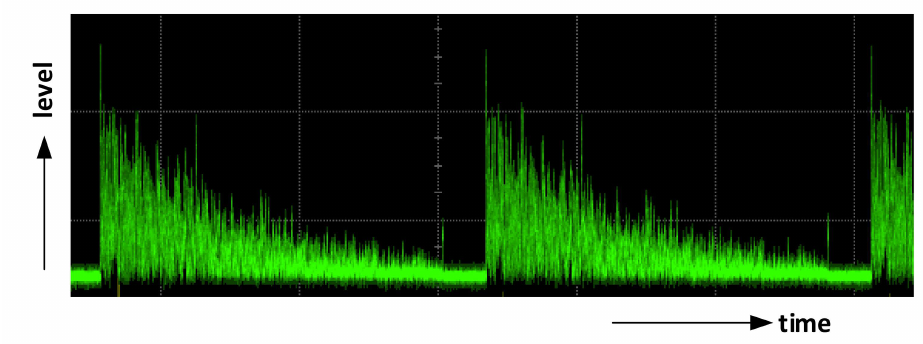
Figure 5. Typical fiber response to narrow spectral linewidth interrogating pulses (result of own experiments).